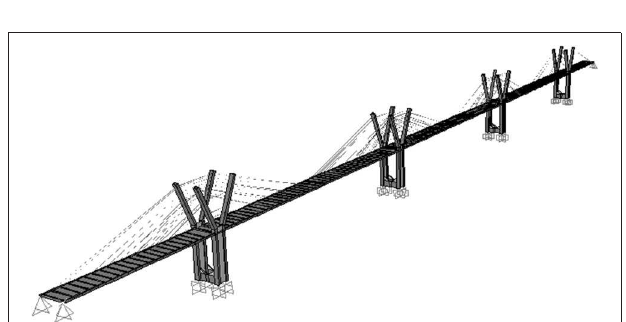
FIGURE 3 | Bridge location (Google, 2018).